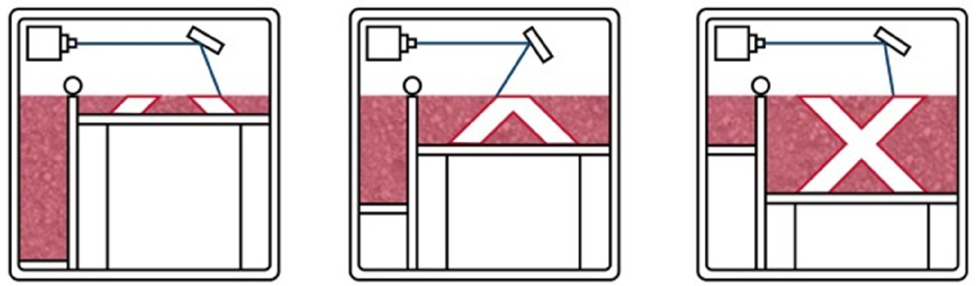
Figure 2. Schematic of a laser powder bed fusion process [20].